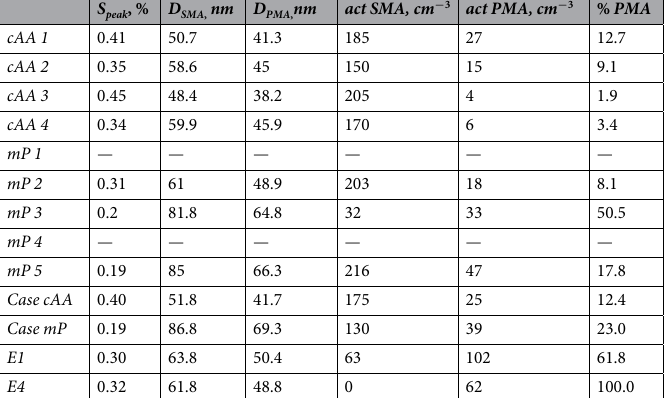
Table 2. Values used for PMA number contribution calculation. Inter-modal minimum (D c ) values gave corresponding cloud peak supersaturation (S peak ) based on ambient S c -D c curves. The same curves resolved the critical diameters of SMA (D SMA ) and PMA (D PMA ) which were used in conjunction with number-size distribution data to find the number of activated SMA and PMA particles and find the percent contribution of PMA (% PMA) to the cloud droplet number. The number concentration of PMA and SMA has an associated ± 5 cm − 3 .